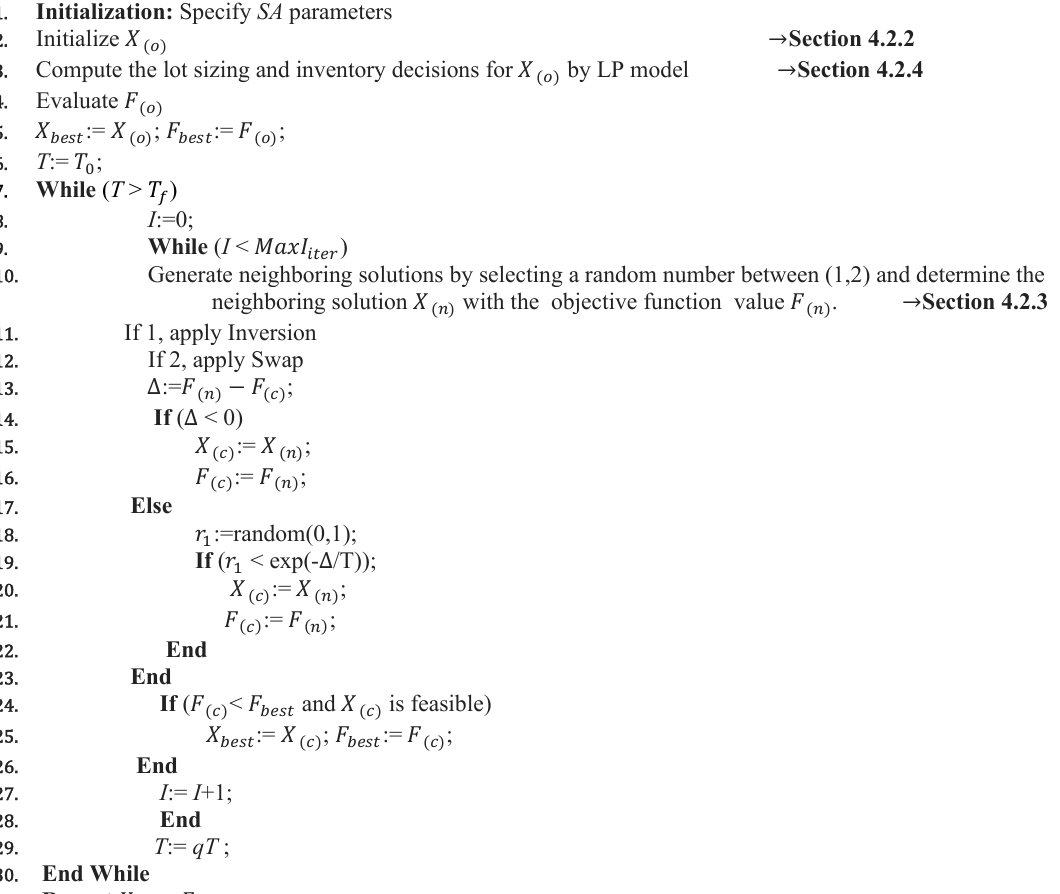
Fig. 3. Pseudocode of the proposed SA-based matheuristic